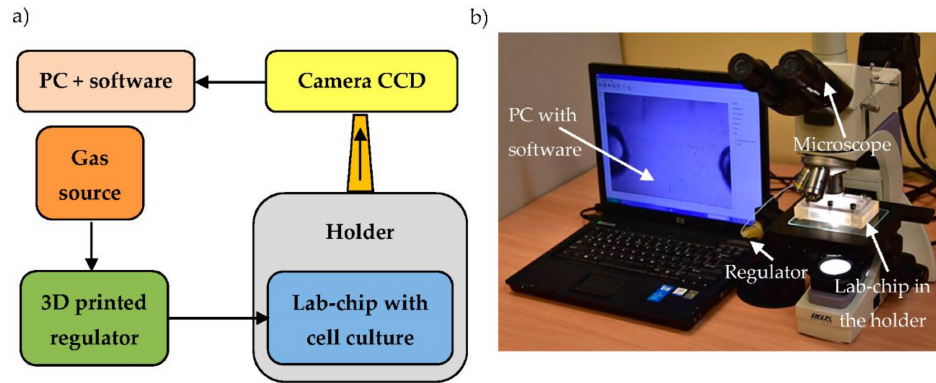
Figure 4. Measurement setup for on-chip cell culture: ( a ) scheme; ( b ) real